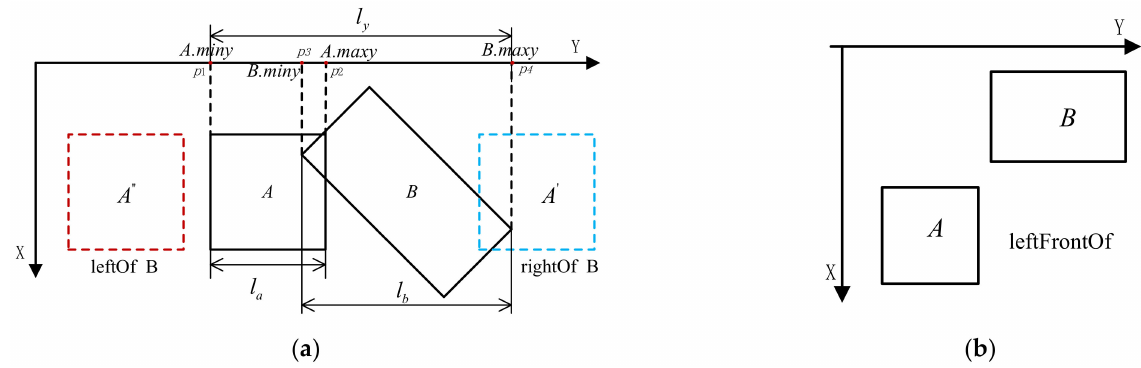
Figure 8. Directional relationships: ( a ) The leftOf and rightOf relationships; ( b ) the leftFrontOf relationships. In some cases, there may be two directional relationships between component B and component A simultaneously. For example, if component A is located at the front-left of component B , as seen in Figure 8b. This two spatial relations are collectively denoted as isleftFrontOf ( A , B ). It depends on the projection of their MBB s on x -axis and y -axis. There also are some similar directional relationships, e.g., leftFrontOf ( A , B ), rightFrontOf ( A , B ), etc. If component A is located in the eight sub-spaces around the reference component B such as left_above_back, left_above_front, etc., there will be corresponding relation- ships leftFrontAboveOf ( A , B ), and rightFrontOf ( A , B ), etc., between them. Similarly, these directional relationships are defined on the x -axis, y -axis, and z -axis